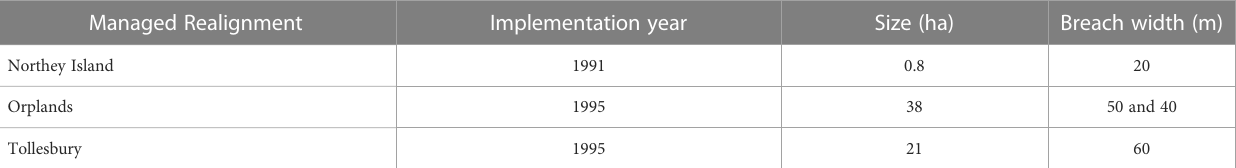
TABLE 1 Implementation year, size, and breach width of managed realignment site